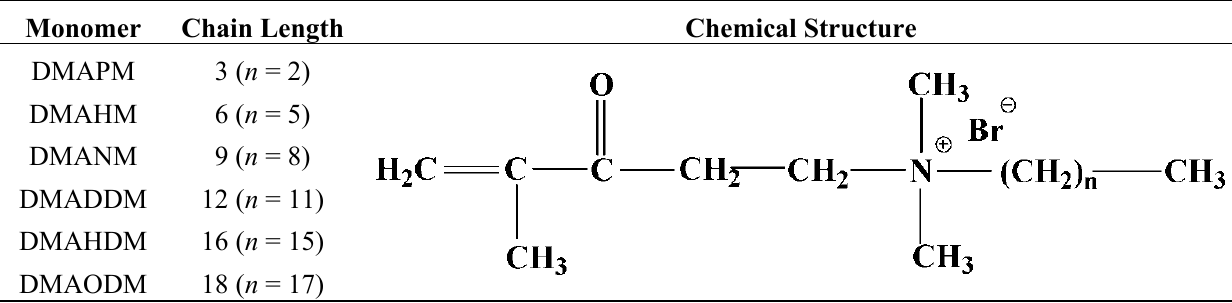
Table 3. Quaternary ammonium monomers of different chain